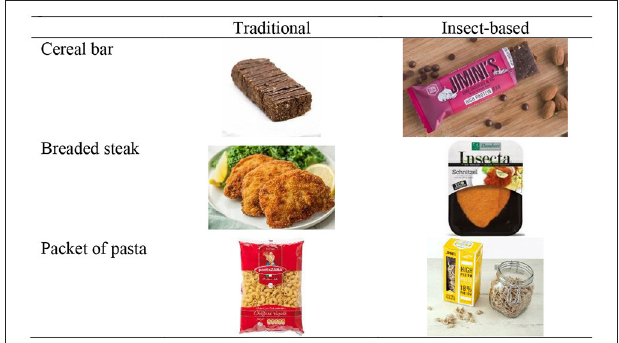
FIGURE 1 | Photos of traditional and insect-based products shown to consumers. Cerel bar traditional: Gluten Free on a Schoestring. Homemade protein bars (2017). Available online at: https://glutenfreeonashoestring.com/ homemade-protein-bars/ (accessed May 1st, 2019); Cereal bar insect-based: The Guardian. Grubs up: Carrefour offers Spanish shoppers insect-based snacks (2018). Available online at: https://www.theguardian.com/world/2018/ apr/19/grubs-up-supermarket-offers-spanish-shoppers-insect-based-foods (accessed May 1, 2019): Breaded steak traditional: The Pruce Eats, Authentic Wiener Schnitzel Recipe. Available online at: https://www.thespruceeats.com/ wiener-schnitzel-recipe-1447089 (accessed May 1, 2019). Breaded steak insect-based: Pinterest. Nuggets, burguer et escalope d’insectes par Damhert (Belgique). Available online at: https://br.pinterest.com/pin/ 324892560598792309/visualsearch/?x=16&y=10&w=517&h=320 (accessed May 1, 2019). Pasta traditional: SXM Distributors. Pasta Zara Garmignone. Available online at: http://sxmdistributors.com/dt_gallery/pasta-zara/pasta- zara-garmignone-500g-550x550/ (accessed May 1, 2019). Pasta insect-based: Twitter. Jimini’s protein bar (2017). Available online at: https:// twitter.com/jiminisfood/status/905116066610851840 (accessed May 1,